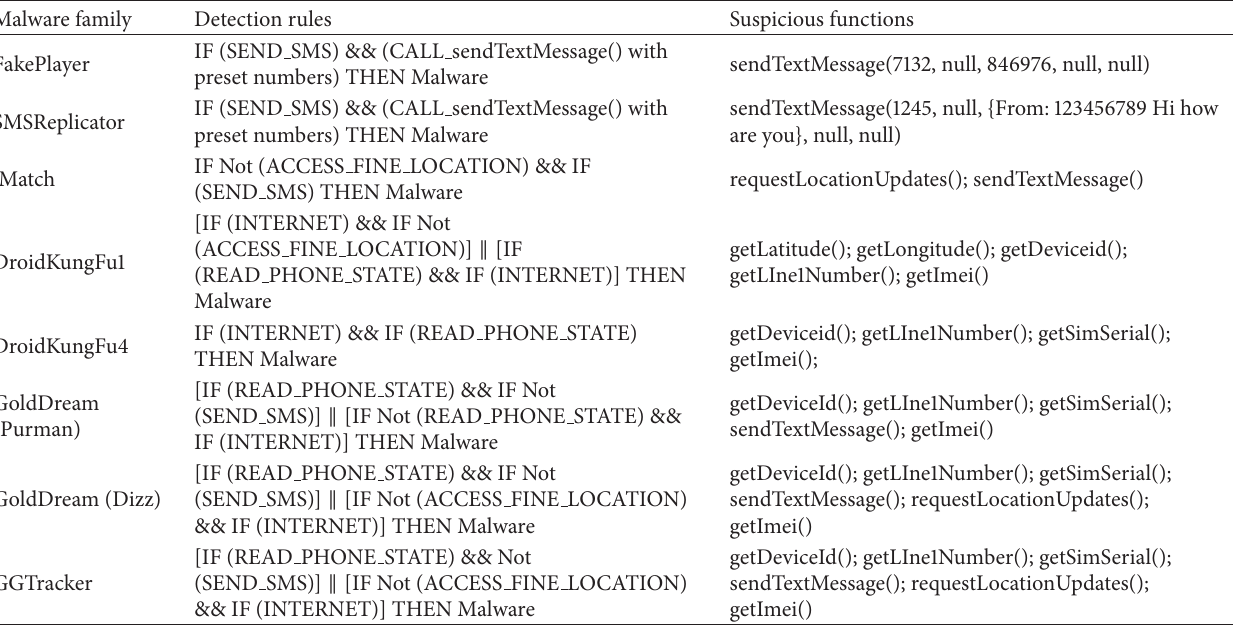
Figure 6: Visualization of the DroidKungFu1 malware with full features chosen (i.e., all the checkboxes are activated). Table 1: Malware family, detection rules, and suspicious